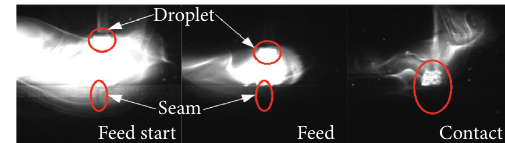
Figure 6: Electrode movement in CMT